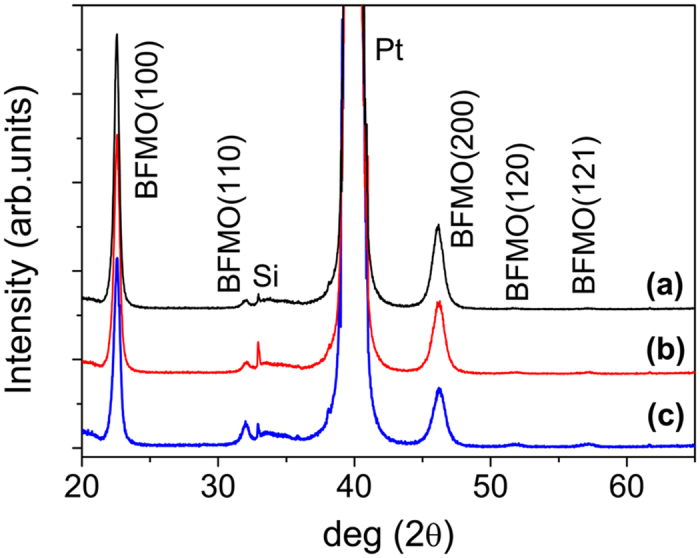
XRD patterns of Bi1-δFe0.95Mn0.05O3 films with different Bi deficiency contents.(a) δ = 0.005, (b) δ = 0.028, and (c) δ = 0.034.